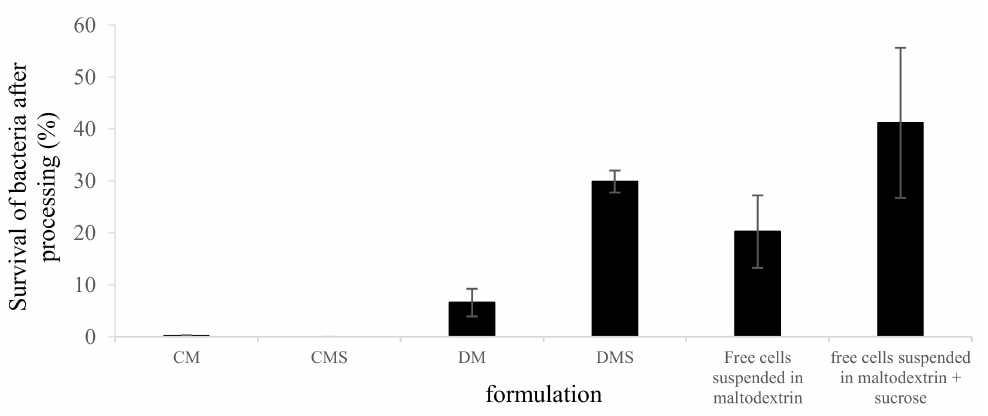
Figure 3. Survival of bacteria after processing. Processing consists of encapsulation (formulations CM, CMS, DM, DMS) or only freeze-drying (other two formulations). Values shown are means ± standards